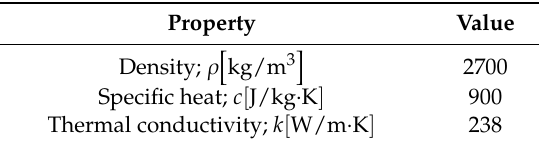
Table 2. Thermo-physical properties of Aluminum